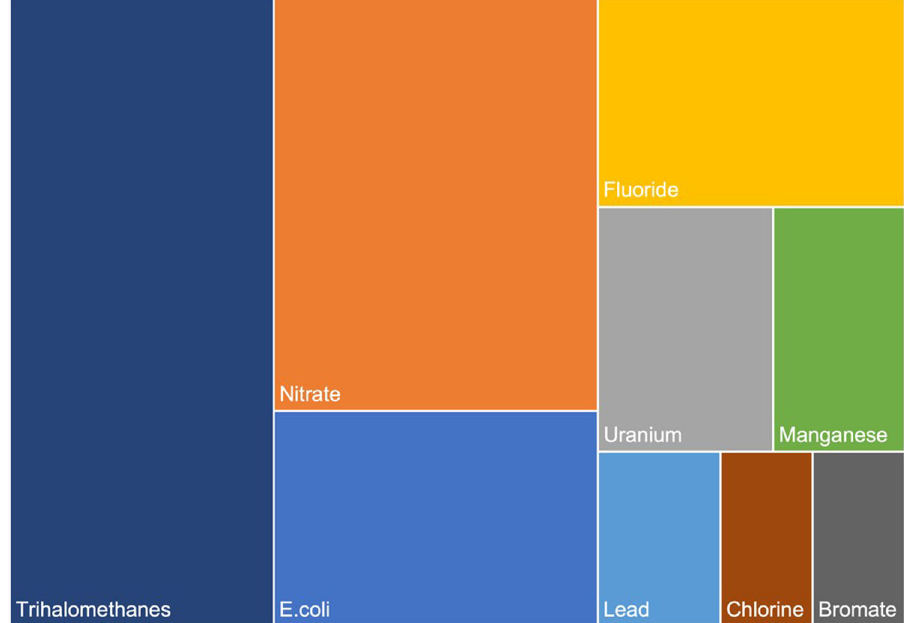
Fig. 4 National composition of exceedances against ADWG health-based guideline values by parameter. Size of coloured rectangles represents the percentage of exceedances associated with the corresponding parameter. Total of 105 exceedances included. Multiple exceedances in the same location against the same health parameter considered to be a single exceedance. Exceedances reported as false positives or not leading to non-compliance with annual jurisdictional compliance targets are not included. 99.1% compliance with Trihalomethanes target across 17 towns in SA Water Barossa system considered to be a single exceedance for this diagram. Single exceedances for Antimony, Barium, Dichloro ‐ acetic and Trichloro ‐ acetic Acid, PFHxS/PFOS not displayed. Source data are provided as a Source Data fi